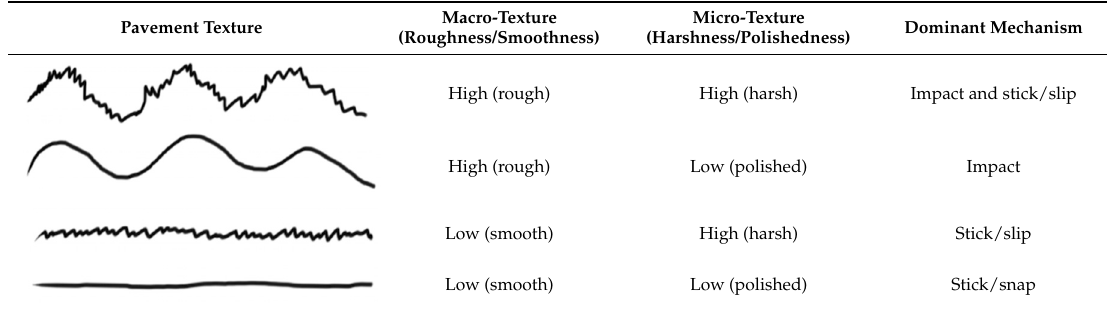
Table 13. Examples of different pavement textures (modified from Thrasher et al., 1976 [192]).